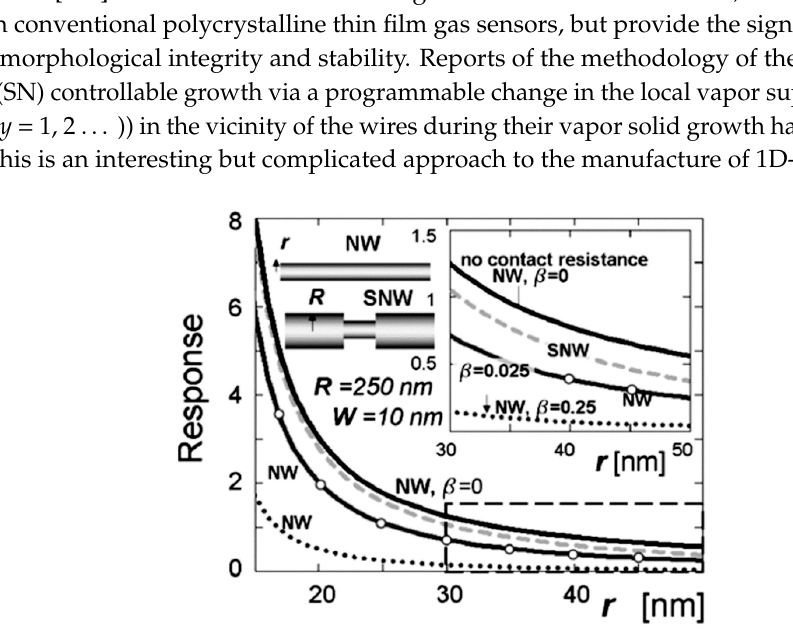
Figure 19. The response of straight and segmented nanowires as a function of their radius at various contact resistances ( b = 0, 0.025, 0.25). For segmented nanowires (SNWs), the curve is drawn versus the radius of the smaller segment. The solid curve (top) corresponds to the nanowire with no contact resistance; the dashed curve corresponds to the SNW with thick segments of a 500 nm diameter and b = 0.025; the solid curve marked with circles corresponds to the SNW with b = 0.025; the dotted curve corresponds to the SNW with b = 0.25. The depletion width is ~10 nm at all cases. Reproduced with permission from Dmitriev et al. [274]. Copyright 2007: Institute of Physics.